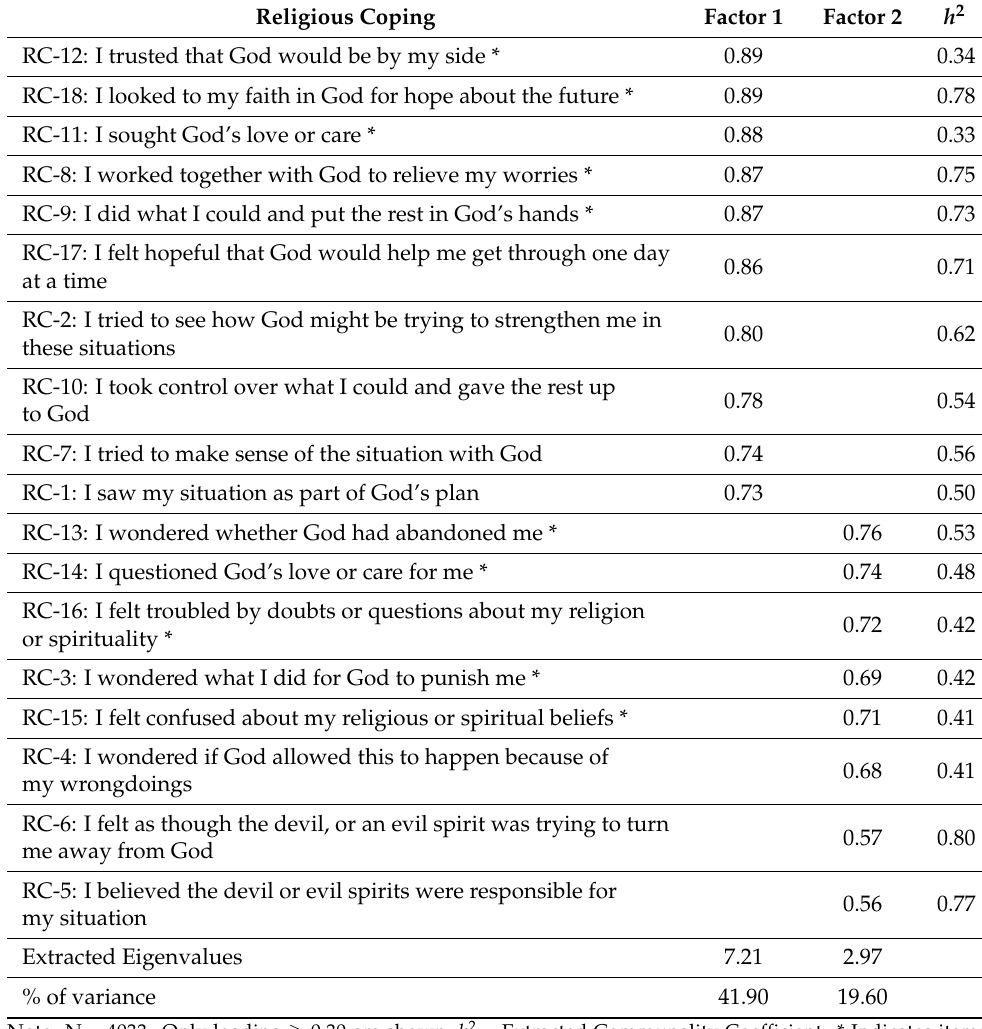
Table 2. Exploratory Factor Analysis (EFA) Principal Axis Analysis with Varimax Rotation for the Religious Coping Items.